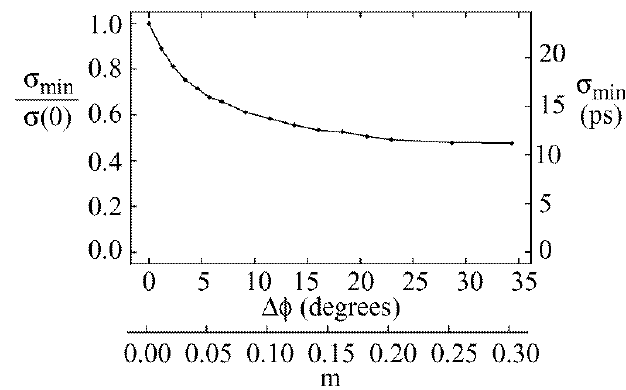
FIG. 10. Minimum bunch length vs phase-modulation ampli- tude from simulation.